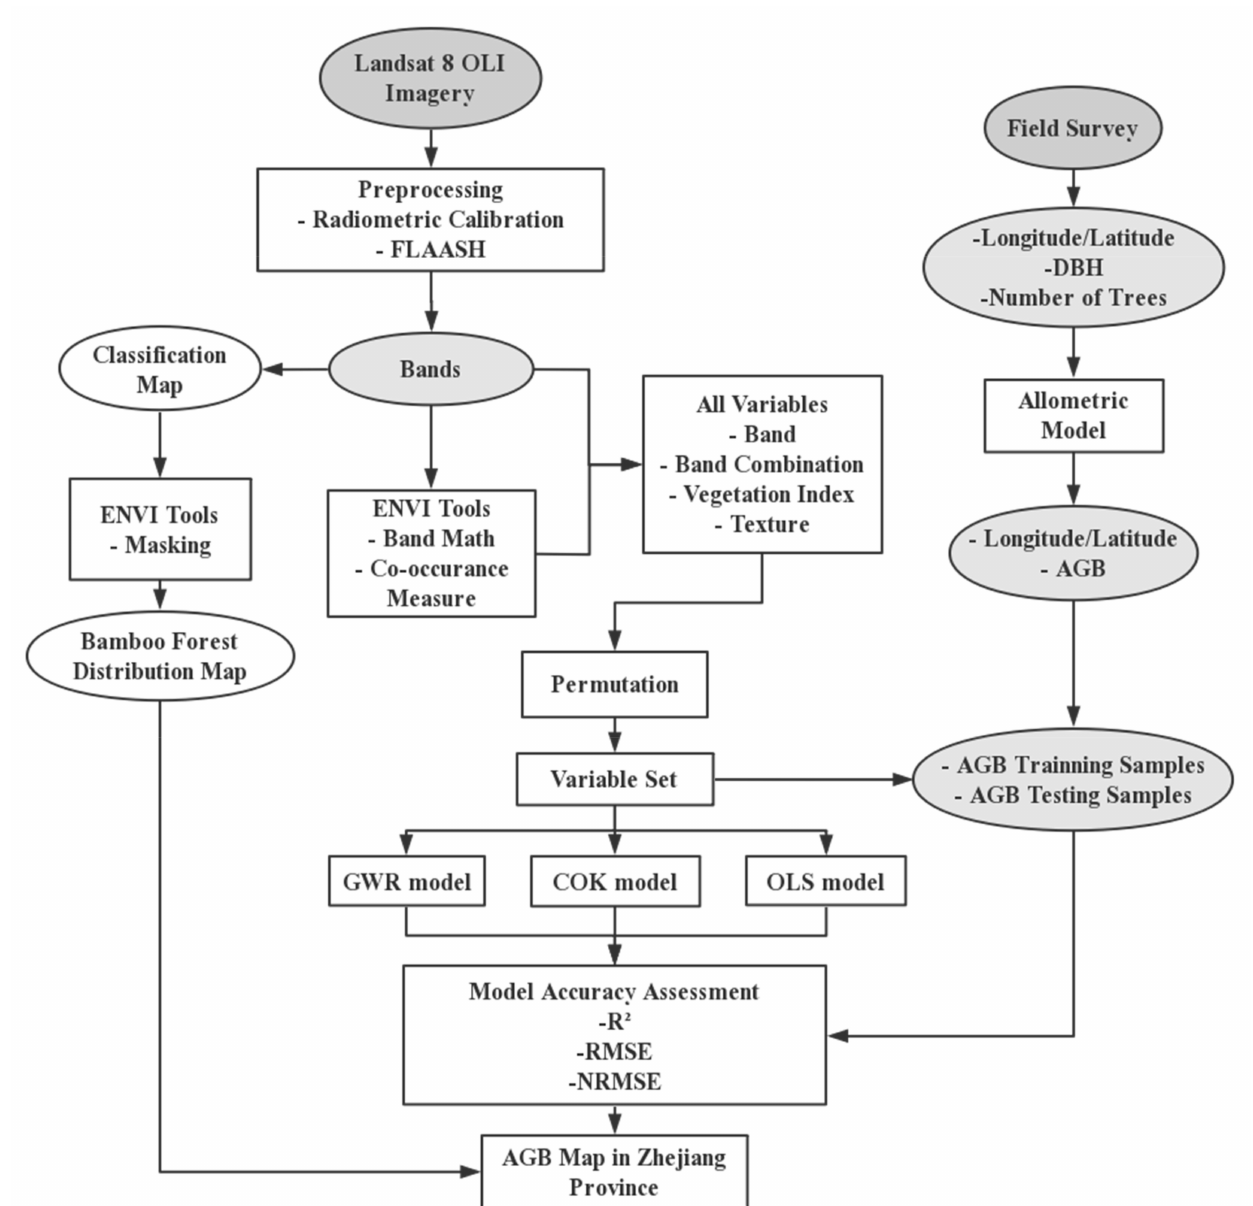
Figure 2. Flowchart of steps used in our study for comparison of different algorithms and variables for bamboo forest AGB